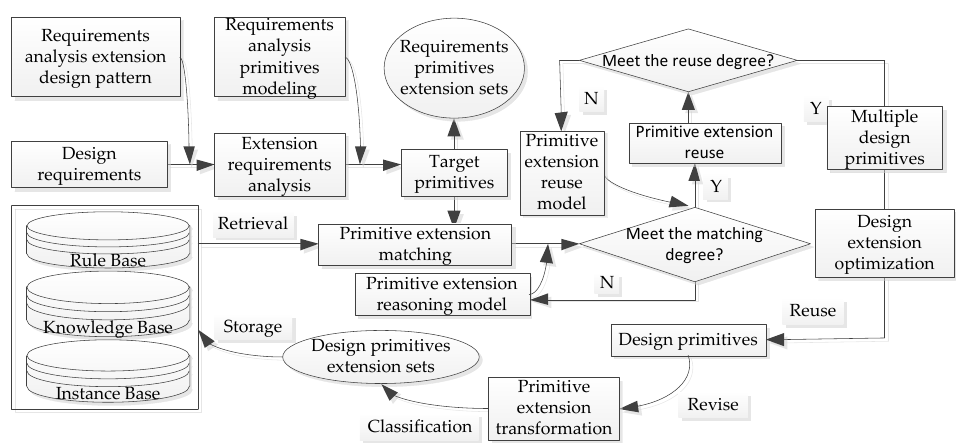
Figure 1. Product conceptual design requirements analysis for extension design patterns.